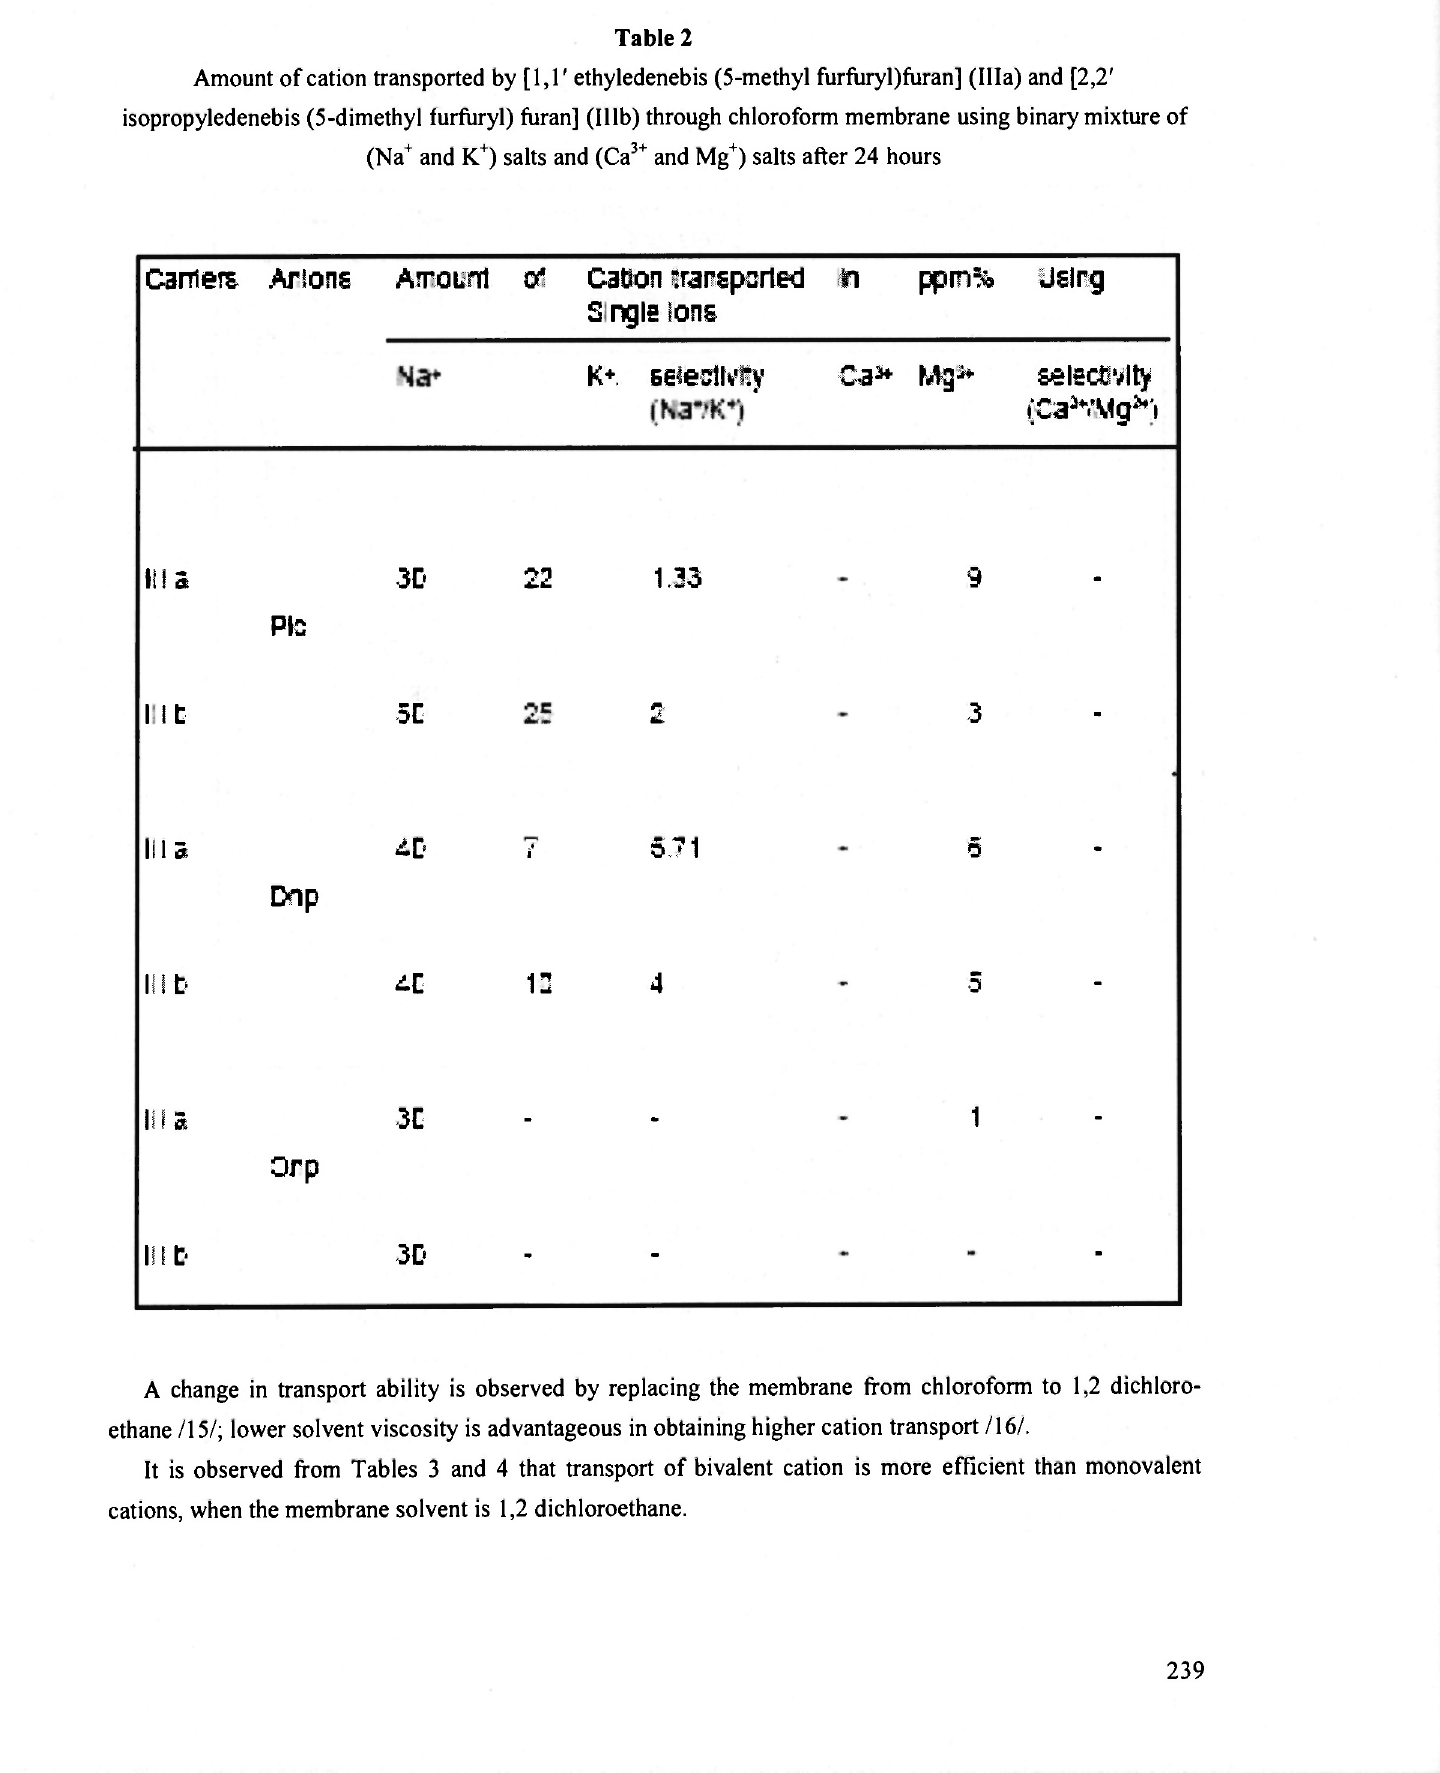
Amount of cation transported by [1,1' ethyledenebis (5-methyl furfiiryl)furan] (Ilia) and [2,2' isopropyledenebis (5-dimethyl furfiiryl) furan] (Illb) through chloroform membrane using binary mixture